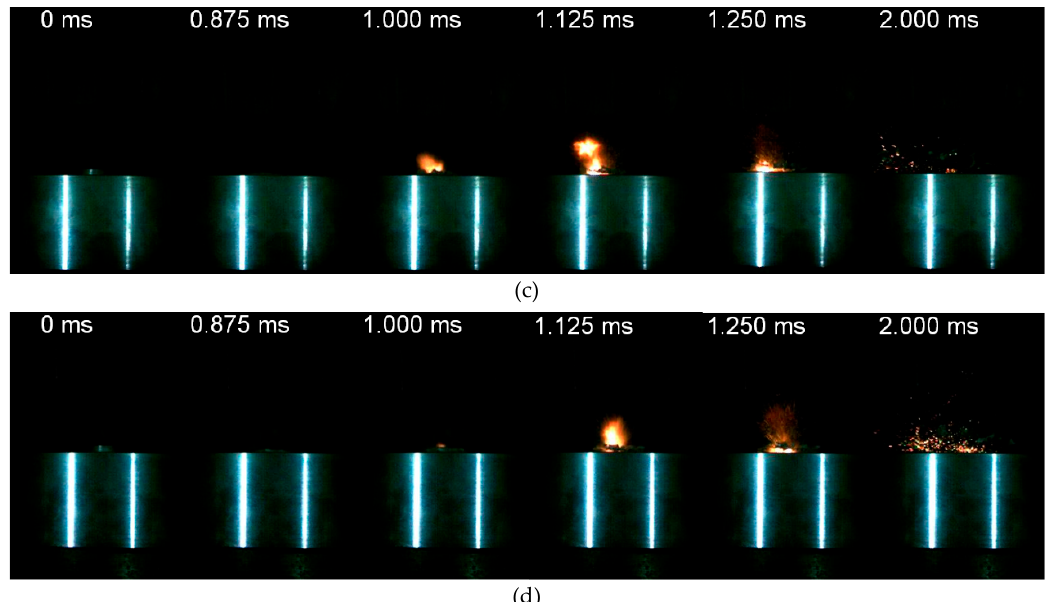
Figure 11. Impact response of the HTSed type E reactive material molded at different pressures: ( a ) 20 MPa; ( b ) 30 MPa; ( c ) 70 MPa; ( d ) 100 MPa.